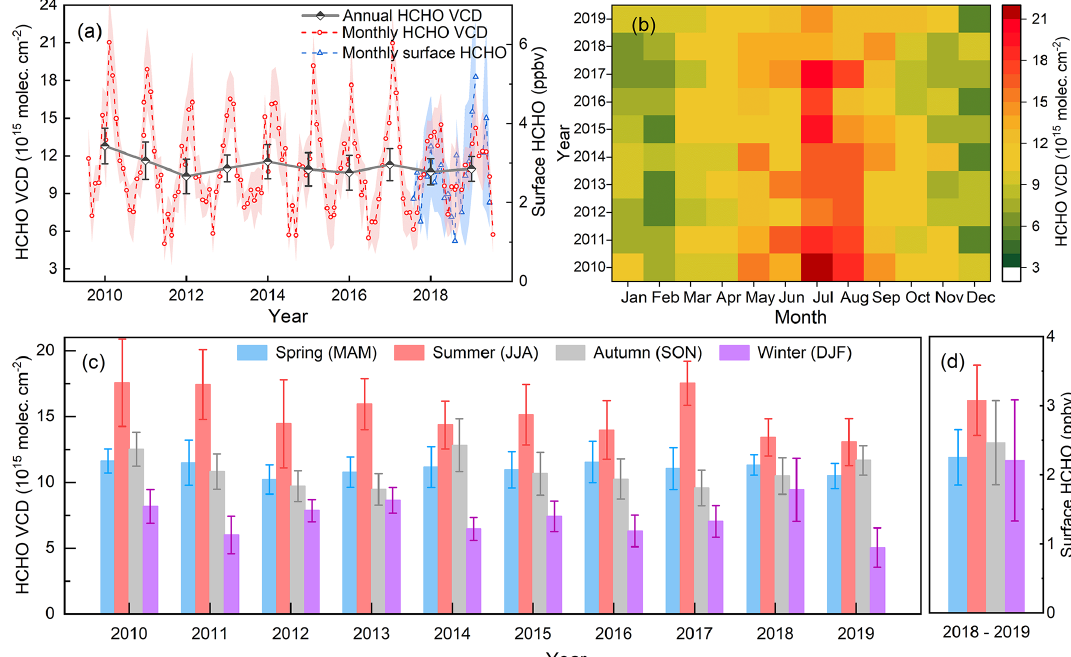
Figure 1. OMI- and LP-DOAS-observed time series of HCHO in Shanghai. Panels (a–c) reflect the annual, monthly, and seasonal variations of HCHO VCD during 2010–2019, and (d) reflects the seasonal variation of surface HCHO during